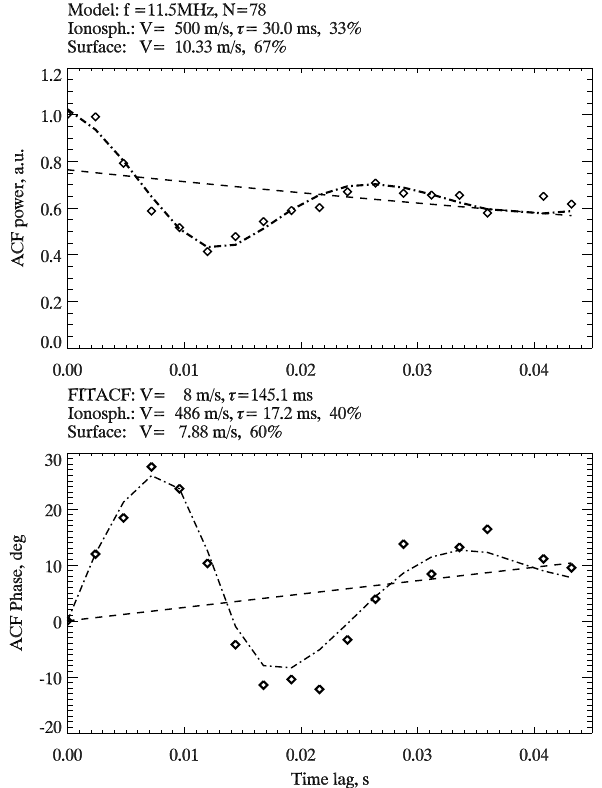
Fig. 3. Simulated example of a “good” ACF (open diamonds) cov- ering ’ 1 1 periods of the interference pattern between IS and SS. 2 The dashed line corresponds to the FITACF fit, while the dash-dot line shows the two-component